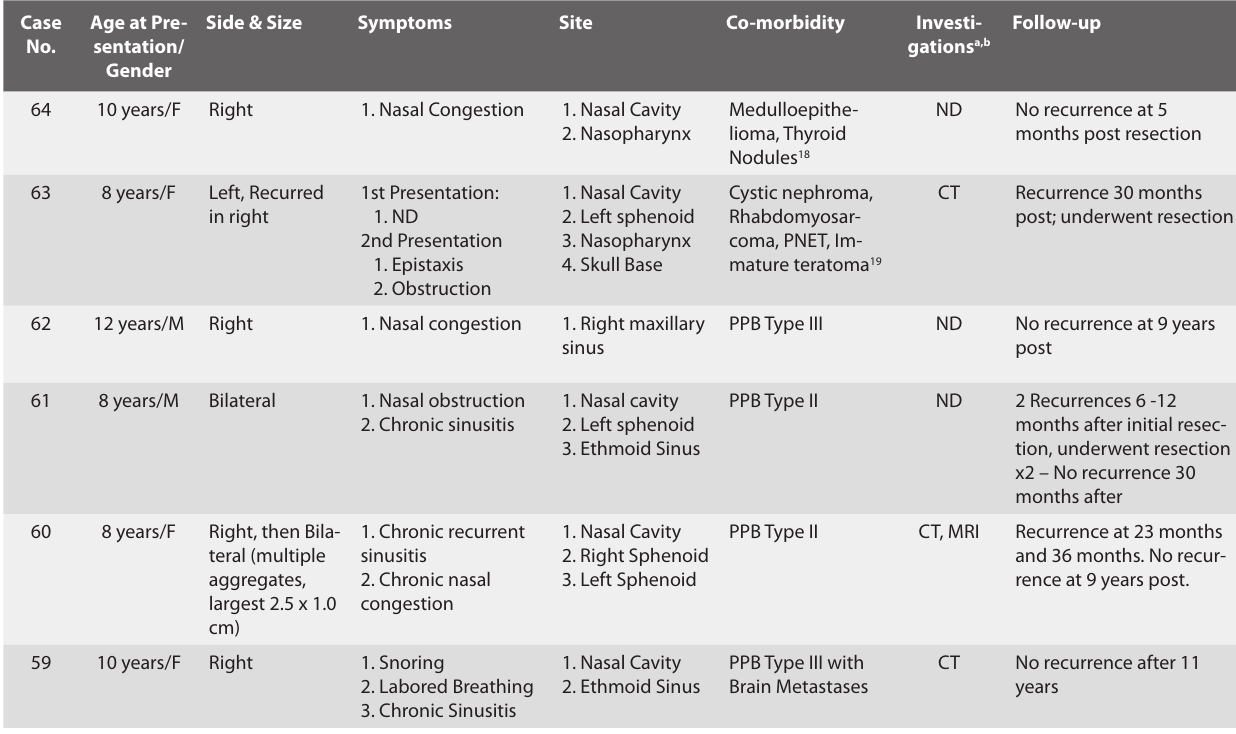
a Fisher’s exact test between DICER 1 -carriers and controls (p-value